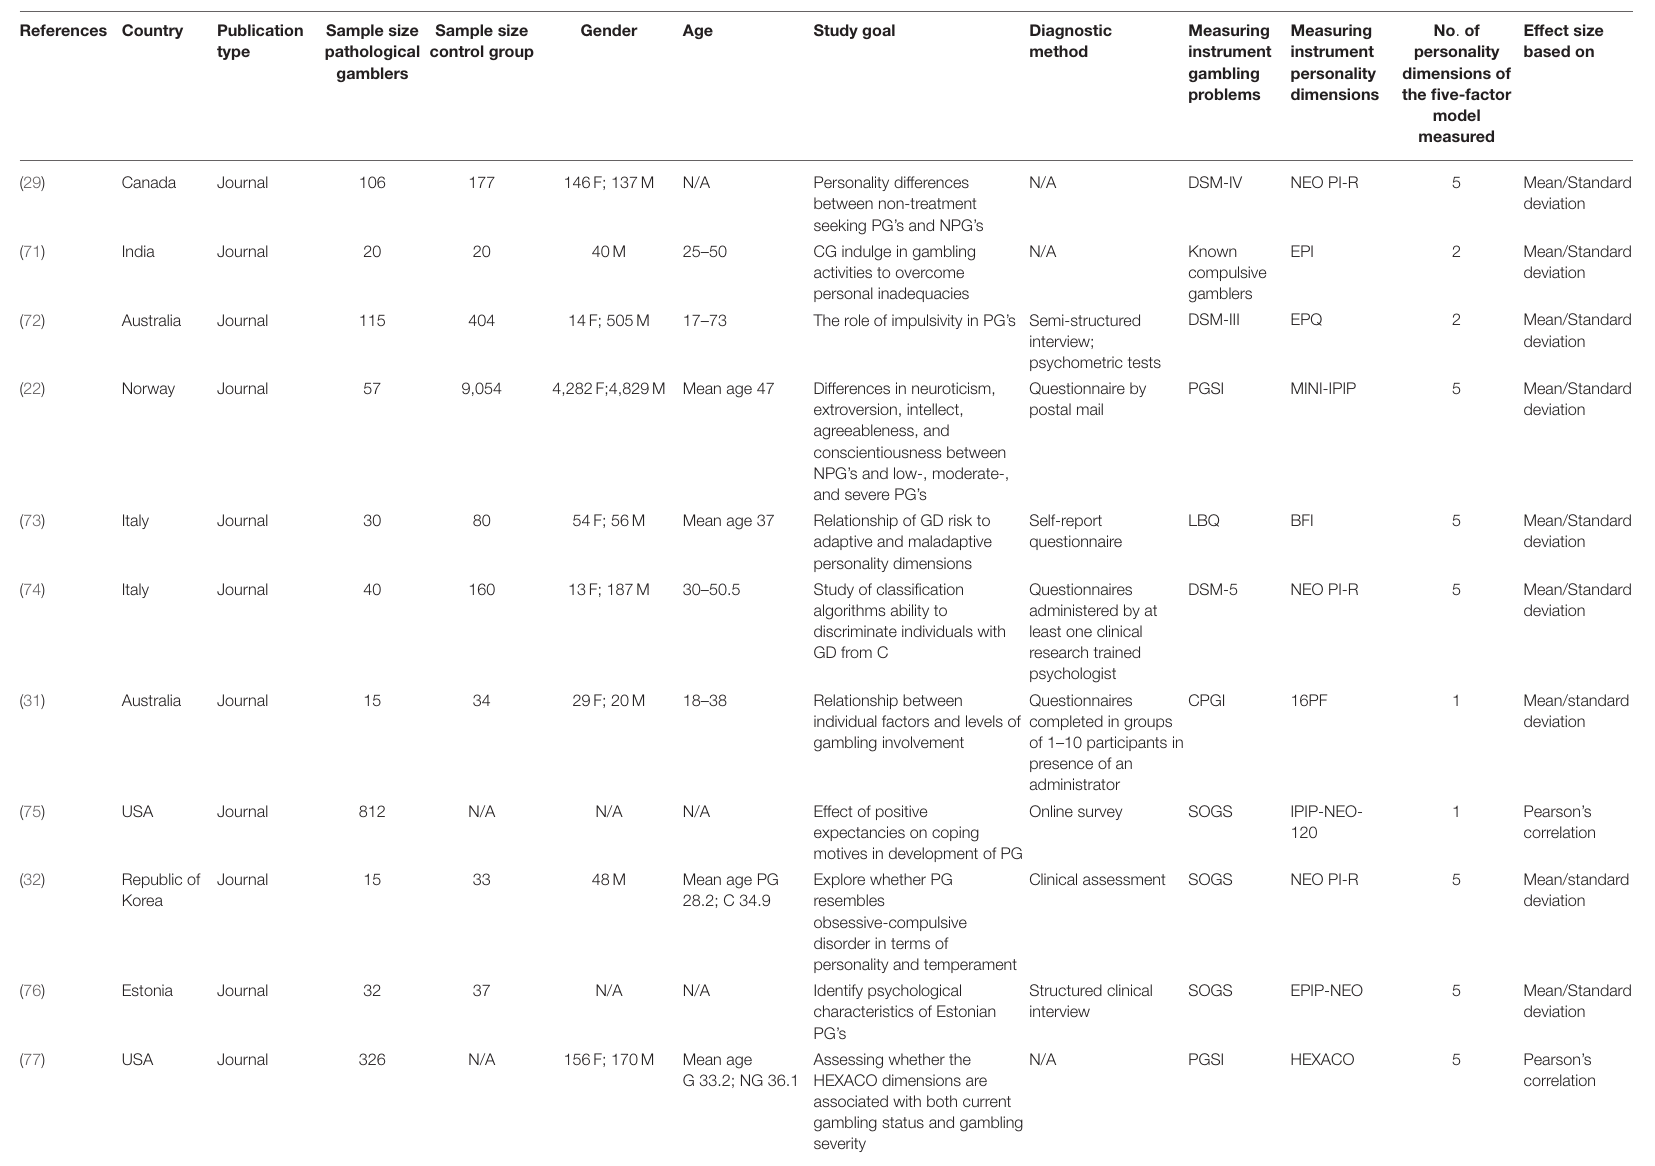
TABLE 1 | Characteristics of study